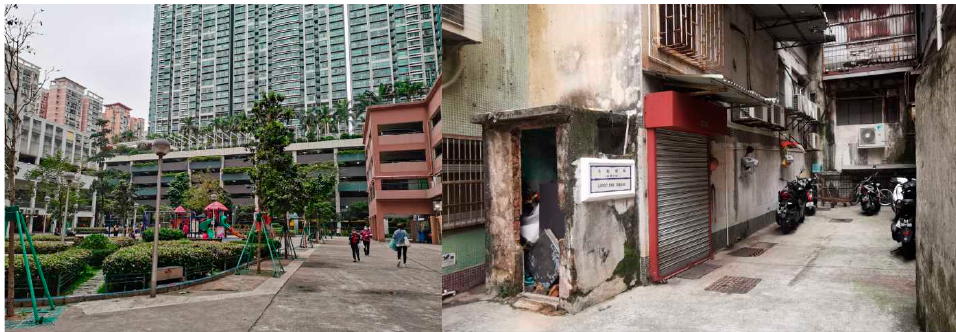
Figure 14. Praça das Orquídeas and Largo das Tábuas.